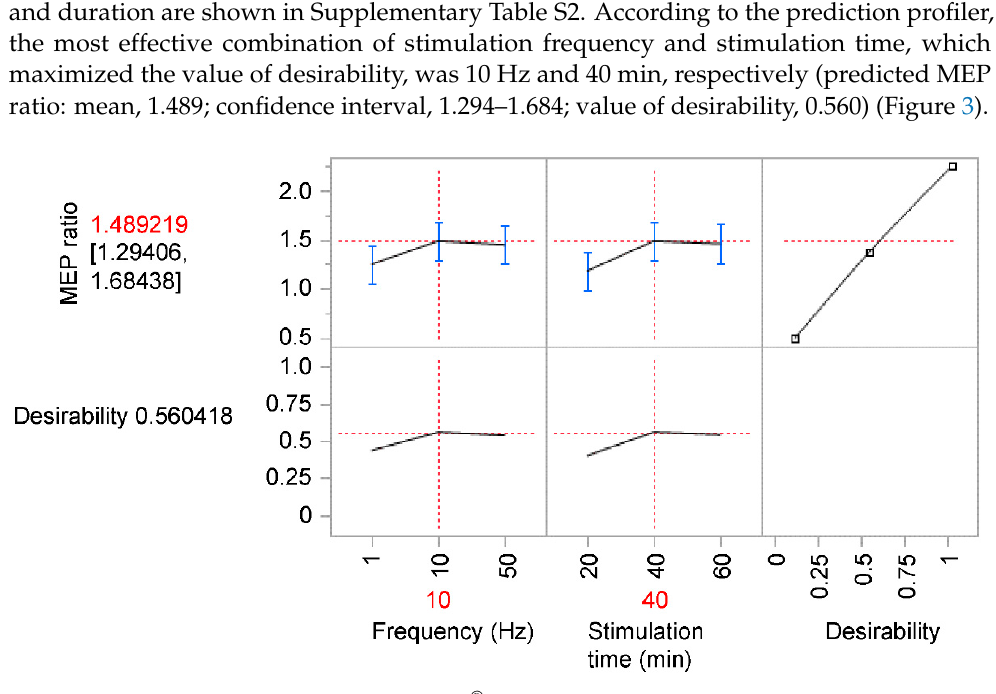
Figure 3. Prediction profiler produced by JMP ® software representing the optimum settings using desirability functions. The most effective combination of stimulation frequency and stimulation time, which maximized the value of desirability, was 10 Hz and 40 min, respectively. The error bar represents confidence interval. MEP, motor-evoked potential. Table 1. Summary of response surface.